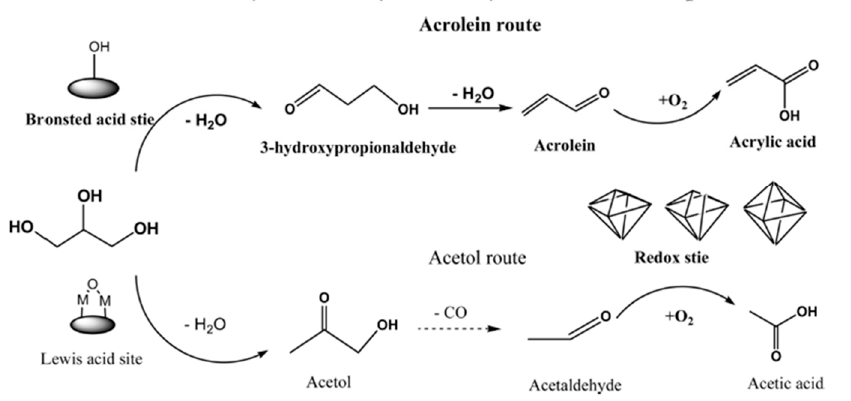
Figure 24. Two different reaction routes in the oxidative dehydration of glycerol depending on the nature of acid sites on the catalyst surface. Reproduced with permission from ref. [220] Copyright © 2018 Elsevier